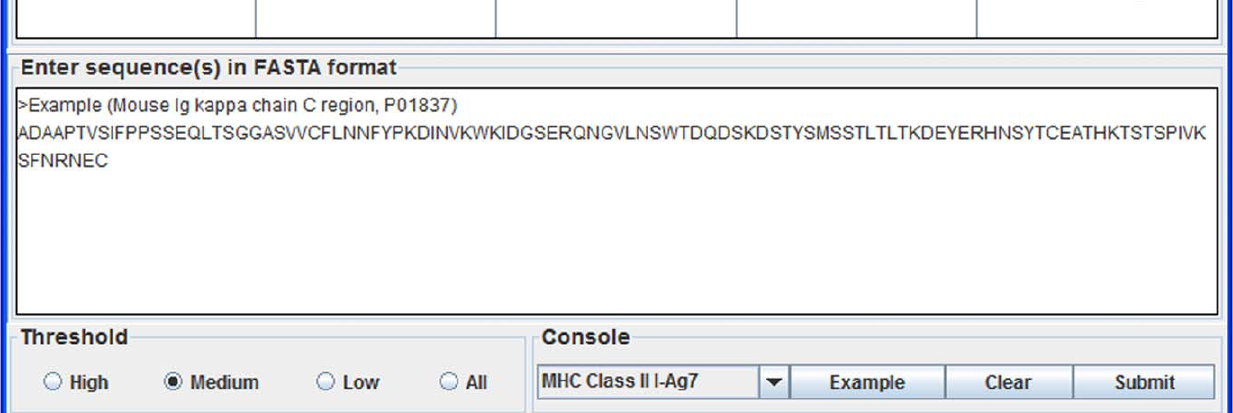
Figure 2. Screen snapshot of the GPS-MBA 1.0 software. The default threshold was chosen for MHC Class II I-A g7 (Medium). As an example, the prediction results for the Mouse Ig k chain C region (UniProt ID: P01837) are shown.